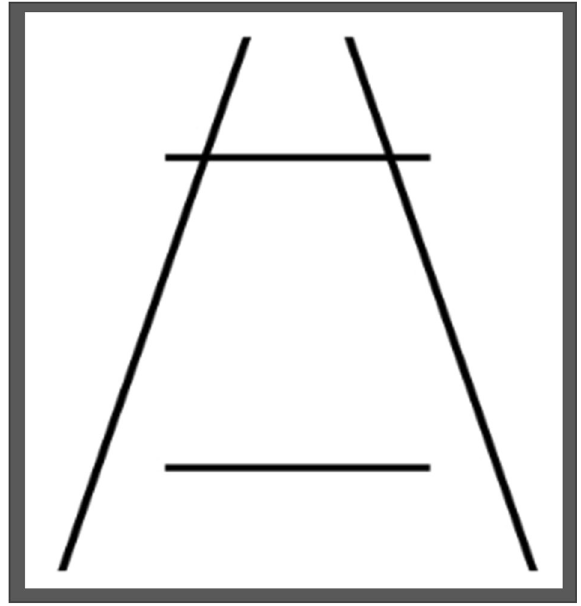
Fig. 2 Depiction of the Ponzo task. Depiction of the Ponzo task. Surrounding contextual information provided by the vertical lines in fl uences the accuracy of length judgements of the horizontal lines. Greater susceptibility to this illusion is related to a global processing